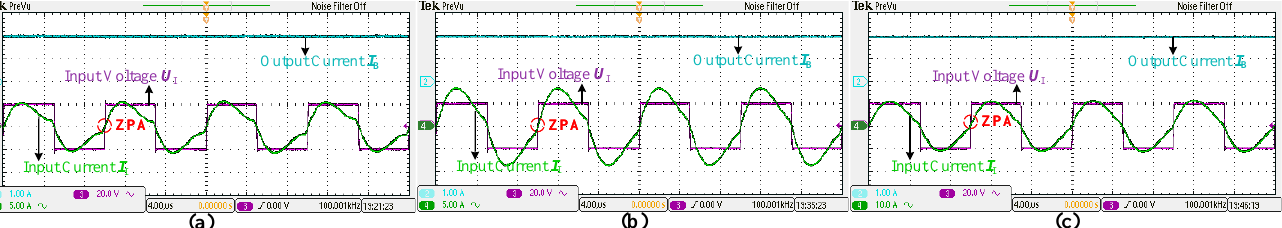
Figure 11. Experimental waveforms of U I , I I and I B under ZPA condition when R B are ( a ) 15 Ω , ( b ) 25 Ω and ( c ) 35 Ω , respectively.